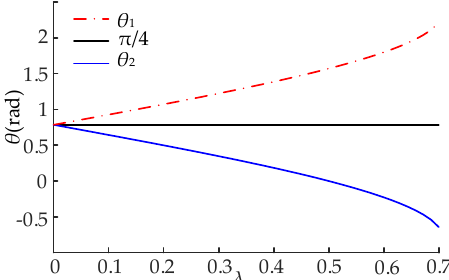
Figure 6. The relation of the noise ratio to the voltage initial phase, which results in the maximum phase error.